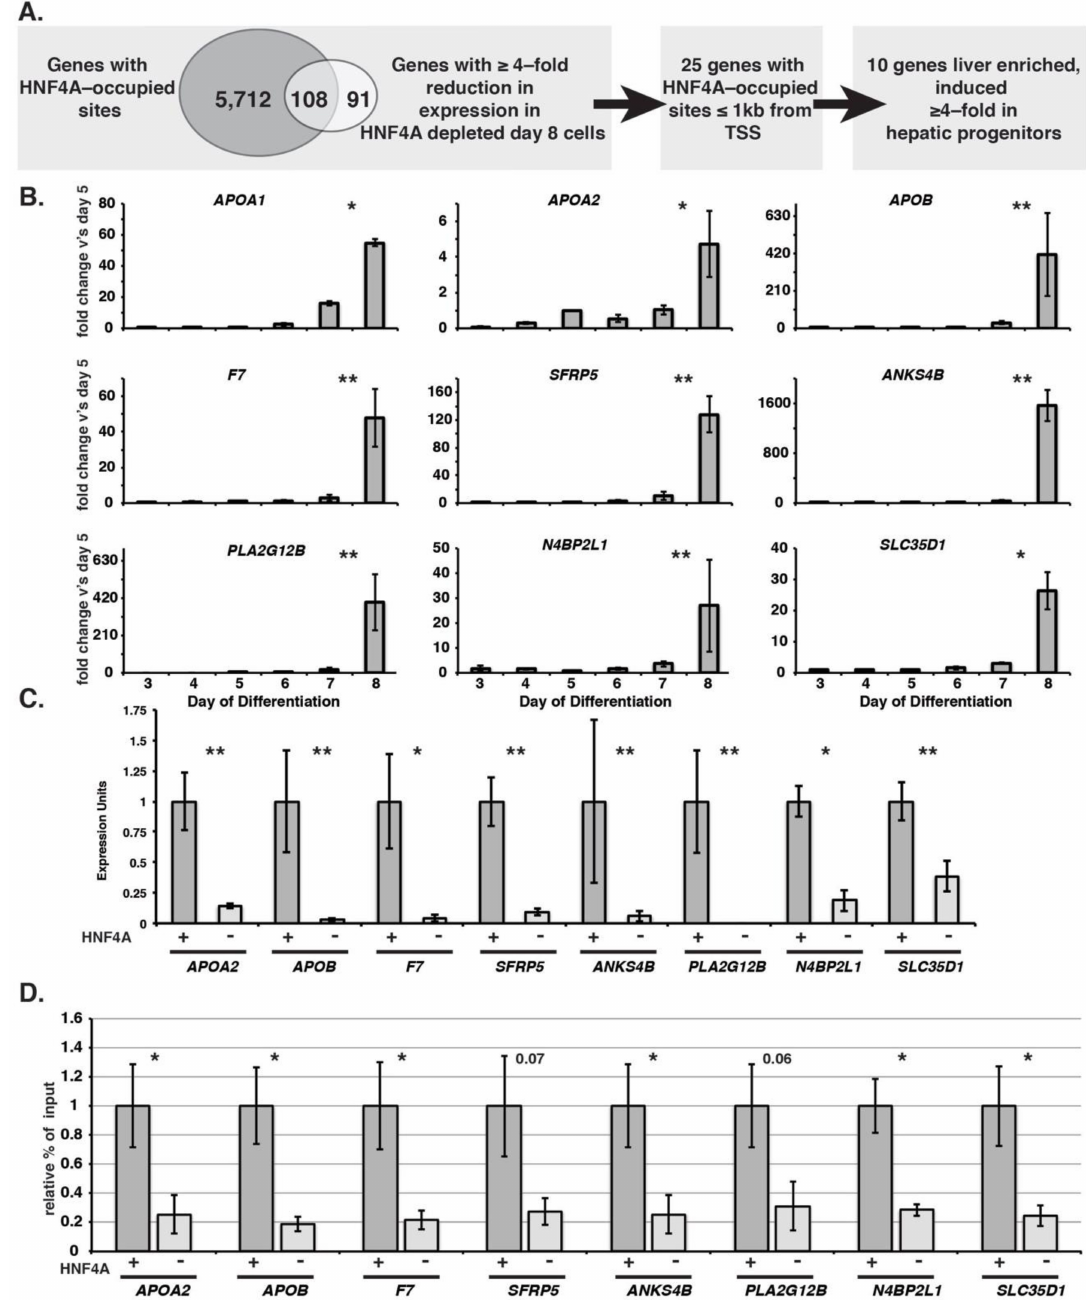
Figure 5. Identification of genes directly regulated by HNF4A during the endoderm to hepatic transition. ( A ) Diagram showing strategy used to identify genes that are direct targets of HNF4A with high confidence; ( B ) Expression profiles determined by RT-qPCR of genes that are direct targets of HNF4A during the transition of iPSC-derived endoderm to a hepatic fate. t -test compared expression levels at day eight vs. day seven; ( C ) Bar graphs showing RT-qPCR analyses of mRNAs expressed from HNF4A target genes in hepatic progenitor cells derived from control and HNF4A depleted iPSCs at day eight of differentiation. ( D ) Bar graphs showing results of ChIP-qPCR analyses of HNF4A occupancy in hepatic progenitor cells derived from control (dark grey) and HNF4A-depleted (light grey) iPSCs at day eight of differentiation. Error bars represent s.e.m, n = 3 independent differentiations. Student’s t -test, (*) p ≤ 0.05. (**) p ≤